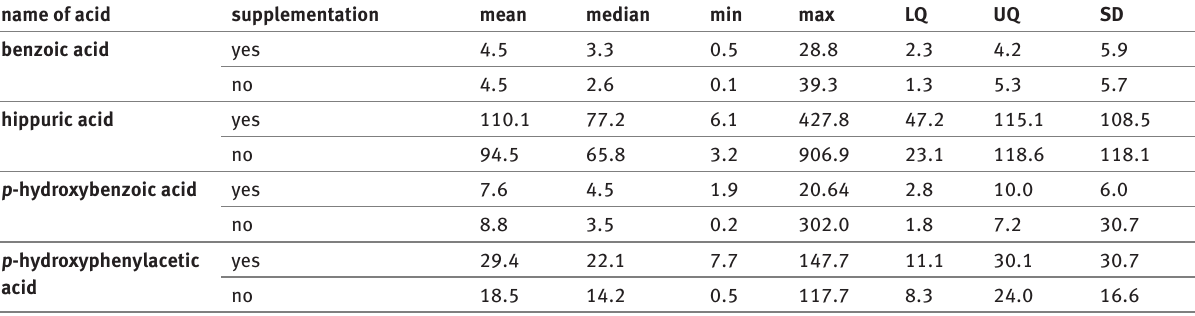
children with and without probiotic supplementation name of